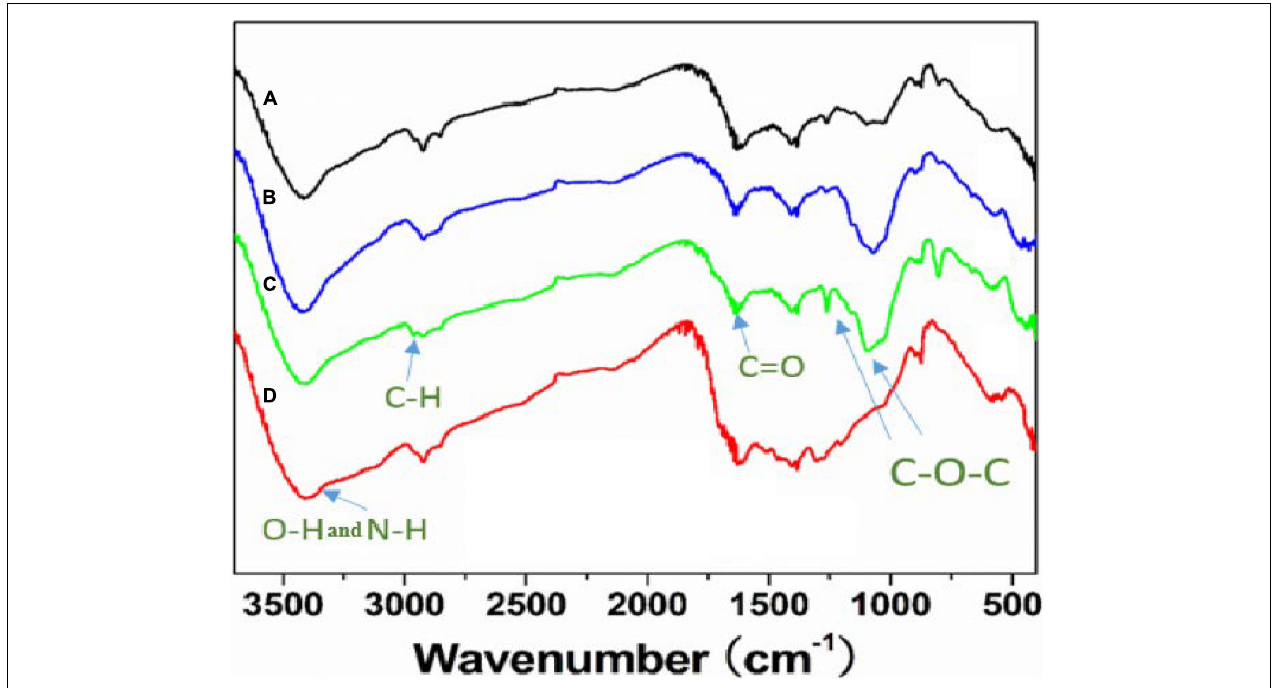
FIGURE 1 | FTIR spectra of different CDs samples prepared from differently pre-treated cellulose hydrogels: (A) CDs-4a; (B) CDs-3a; (C) CDs-2a; (D) Cellulose.